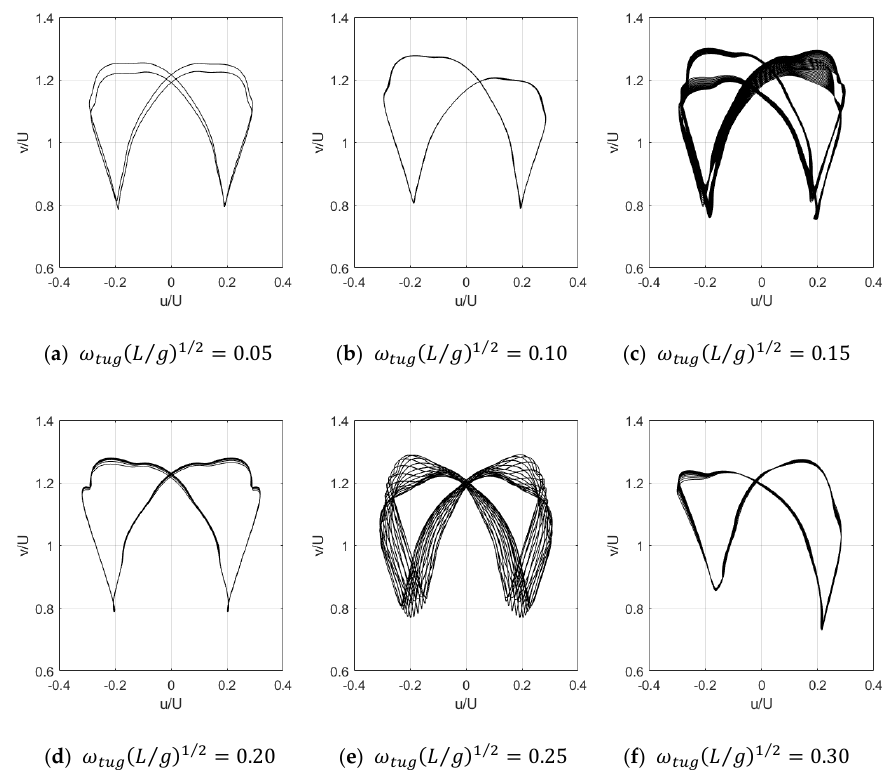
Figure 12. Phase trajectories of the towed vessel with considering tug longitudinal motions ( A tug / L = 0.05 )